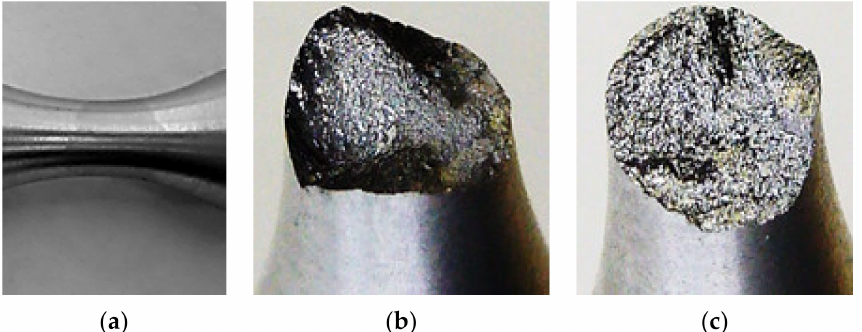
Figure 27. ( a ) The visual evidence of changing the chemical composition due to welding consisting in the change of the colour of the specimens’ welded joint; ( b ) the macro-structure of the fracture surface of the welded specimen stressed multiaxially; ( c ) the nonwelded specimen stressed multiaxially and by low